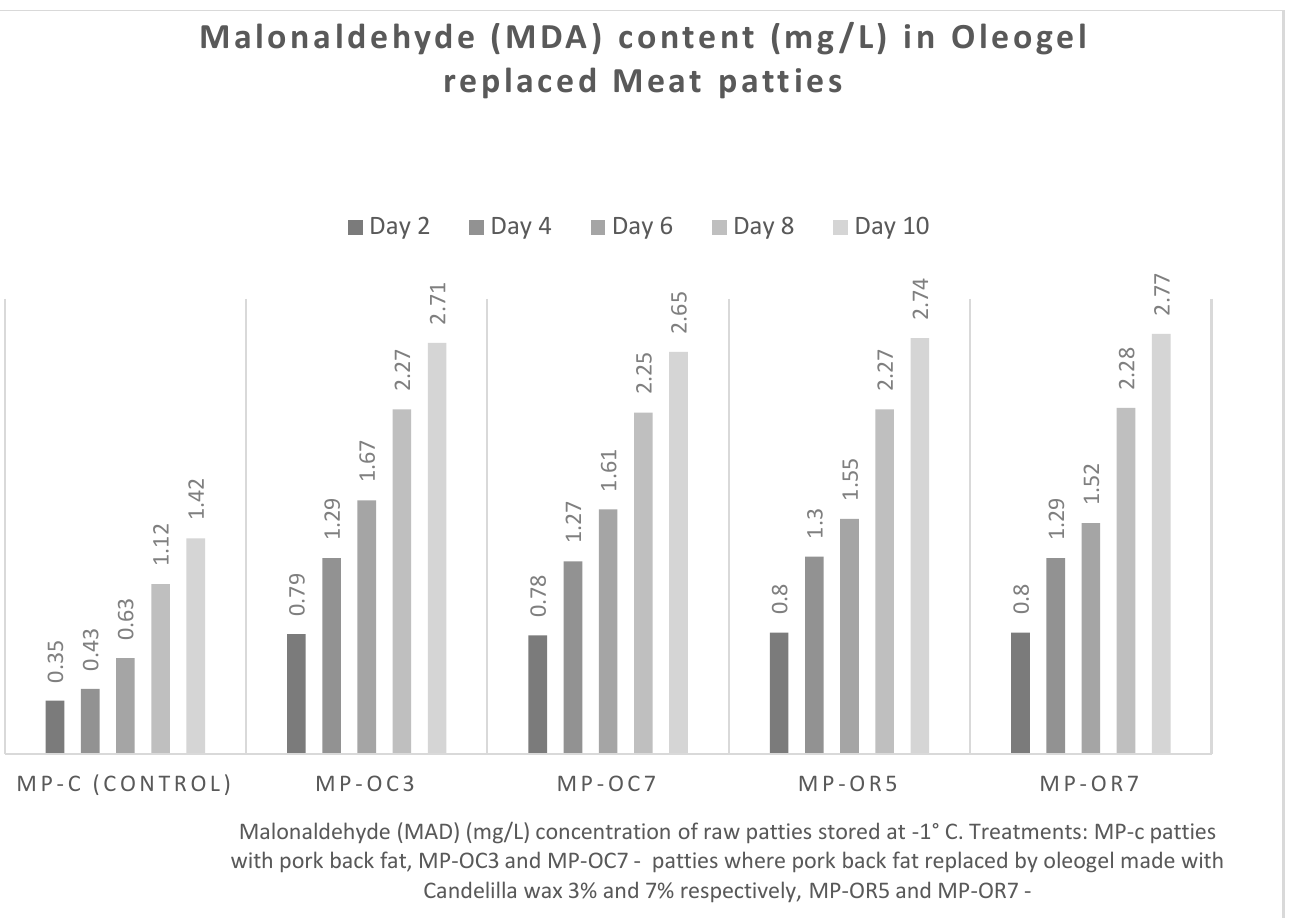
Figure 1. Concentration of malonaldehyde (MAD) of raw burgers during storage 2, 4, 6, 8, 10 days